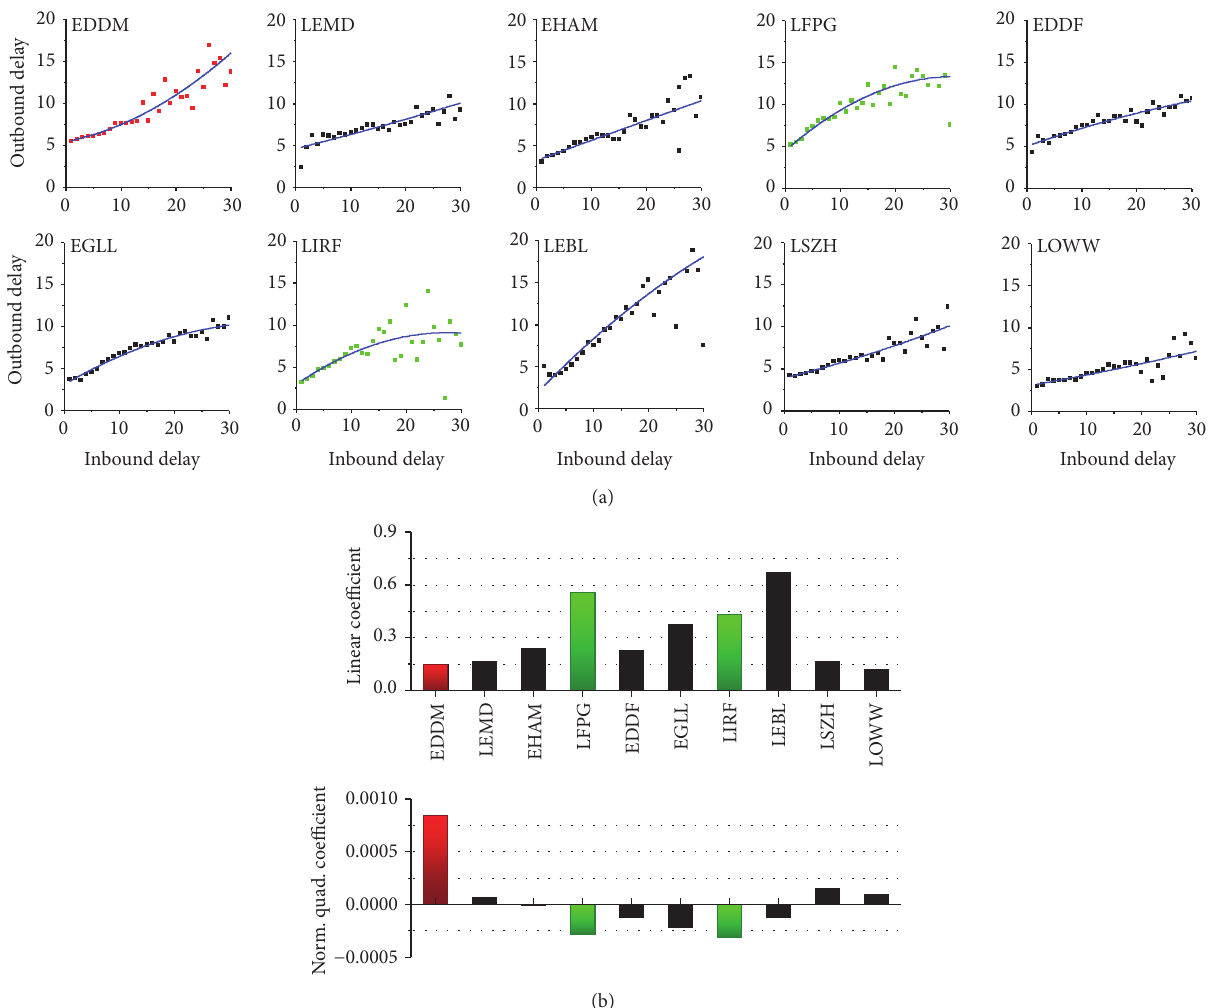
Figure 1: Behaviour of the top 10 European airports for a phase of zero. (a) depicts the ten scatter plots of outbound versus inbound average delays and (b) the sign and magnitude of the linear and normalised quadratic coefficients. Green and red, respectively, represent airports with highly negative and positive quadratic